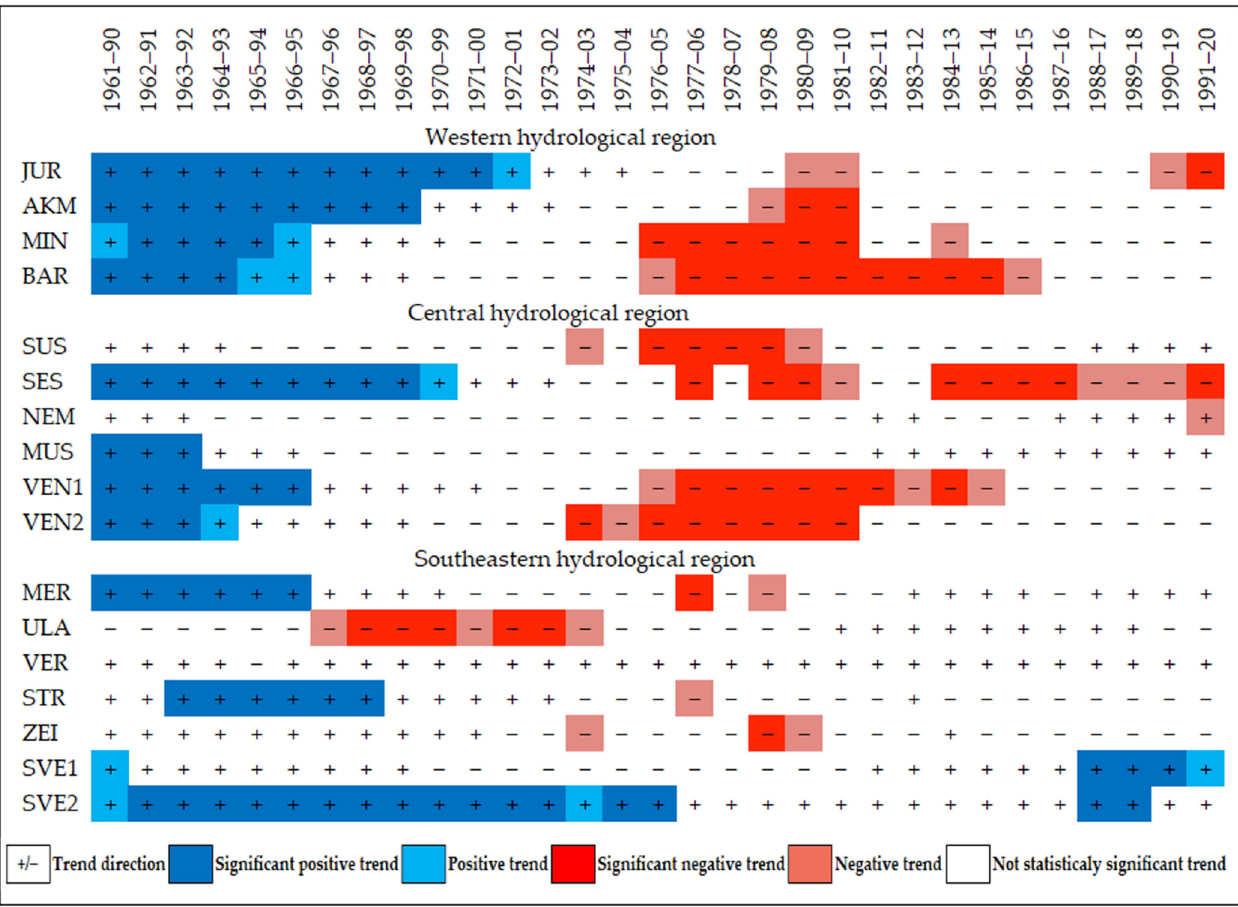
Figure 8. The results of the MK test for 30-year moving averages for 1961–2020 (red/blue color means that the trend is very significant ( α ≤ 0.05), light red/ light blue color means that the trend is significant ( α ≤ 0.1), no color means that there is no significant trend ( α > 0.1)).